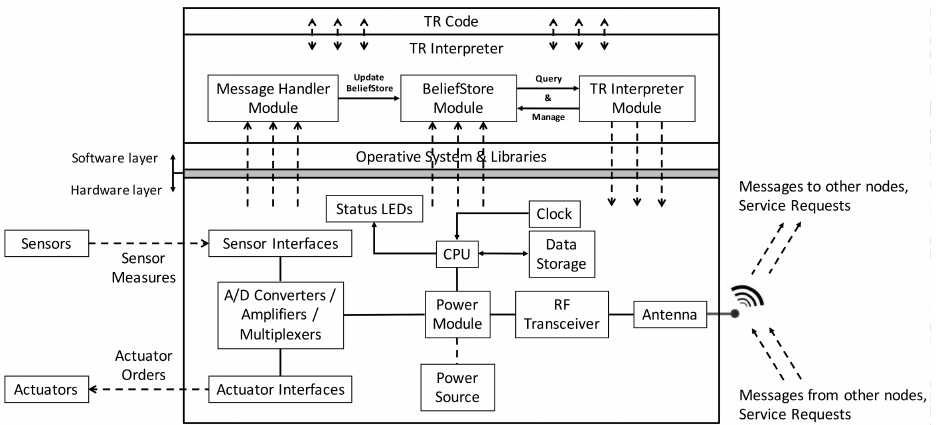
Figure 2. TR node